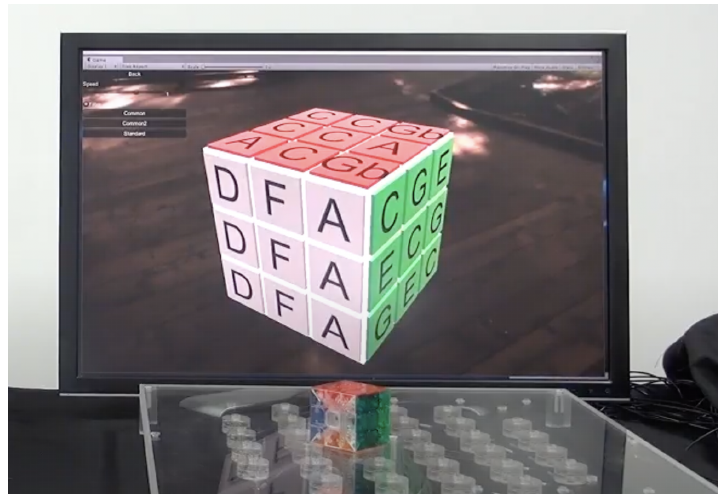
Figure 2. The prototype of CubeHarmonic developed at the Tohoku University, with the IM3D platform and a virtual-reality screen. Detail from a video’s photogram. Video by M. Mannone with Kitamura Lab. CC-BY license for NIME